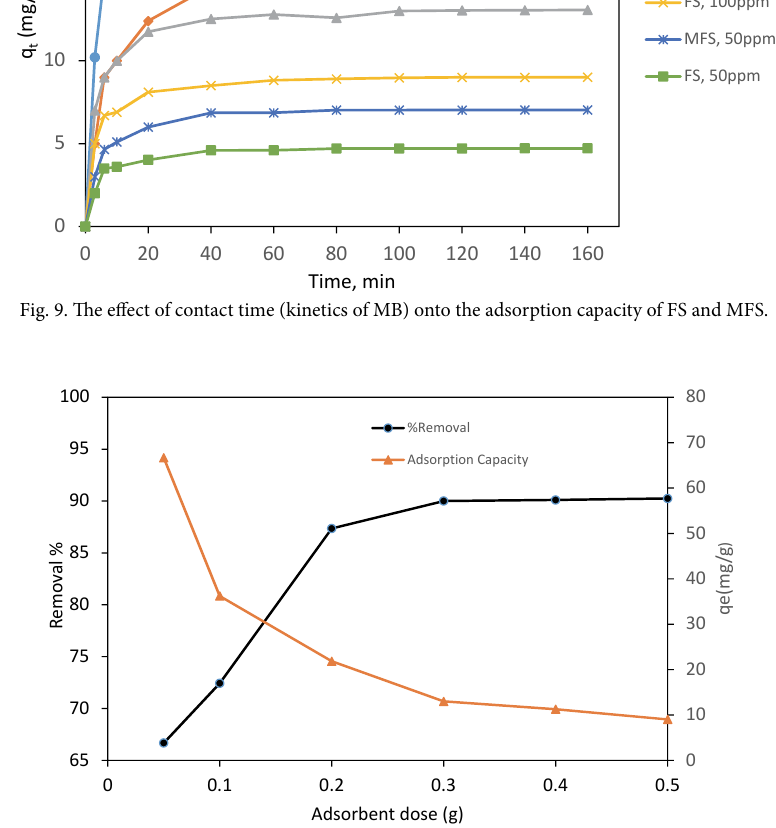
Fig. 10. The effect of adsorbent dosage on MB adsorption capacity and removal percentage.